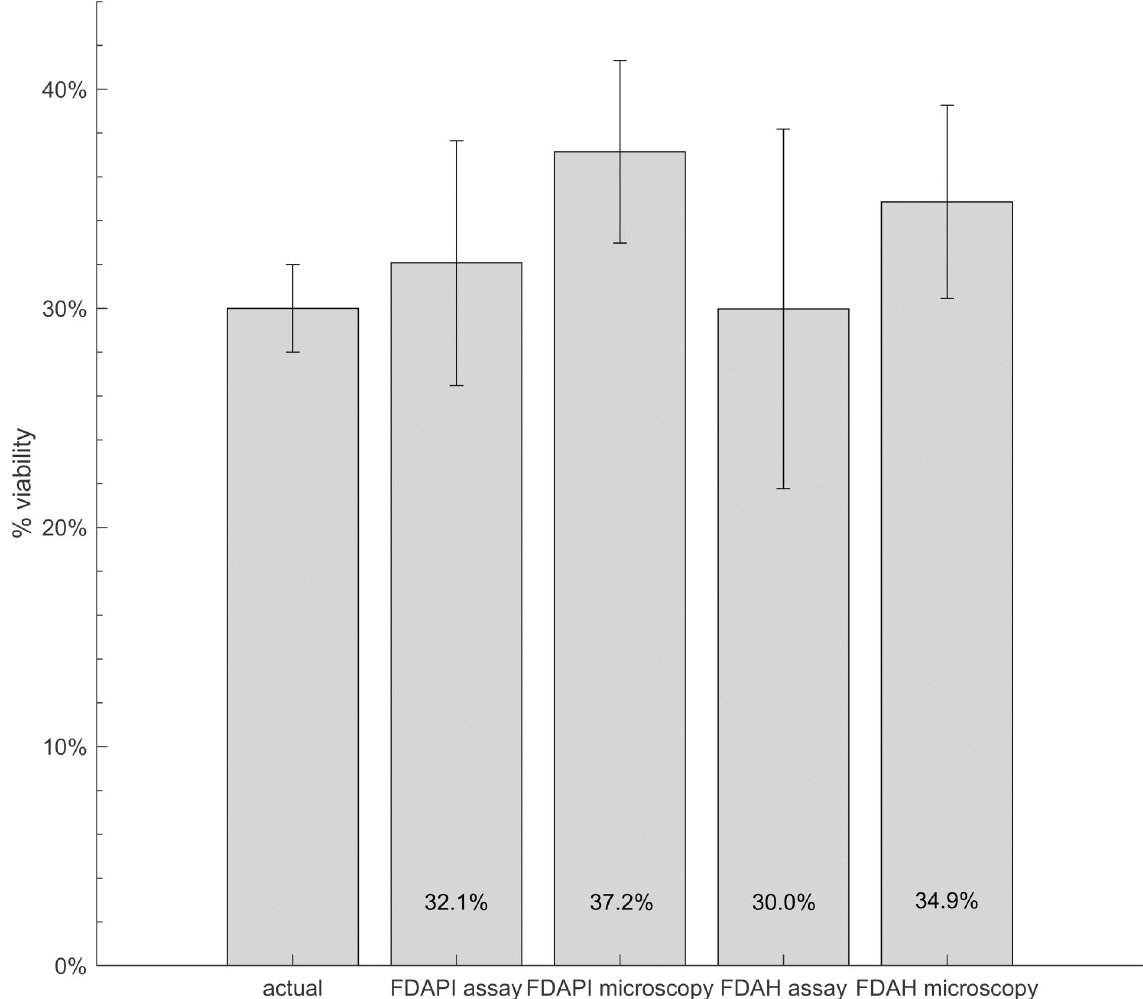
Fig 7. Comparing the viability quantified with fluorescence assays and microscopy. Samples containing 100 ± 4 cercariae with a viability of 30% ± 2% were stained with FDA-PI and FDA-H. Measurements were taken at 20 minutes. Three 50 μ l aliquots of each sample were then examined under the microscope, and cercarial viability was recorded by counting moving (viable) and non-moving (non-viable) cercariae. Average quantified viabilities and SEMs are shown on the bar graph. The “actual” viability is the known proportion of live and dead cercariae in each well, chosen as